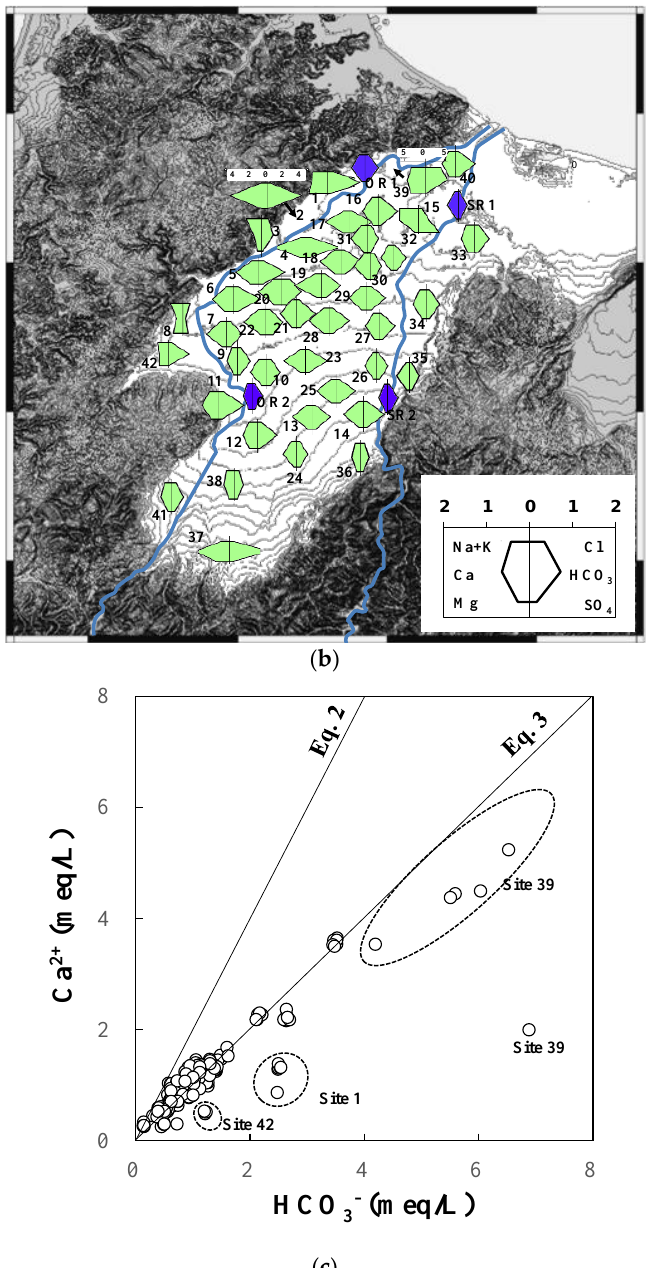
Figure 10. ( a ) Piper and ( b ) Stiff diagrams of groundwater and river water. ( c ) HCO 3 − vs. Ca 2+ . Solid lines correspond to Equations (2) and (3) in the text. Gray and black colors correspond to groundwater and river water, respectively.